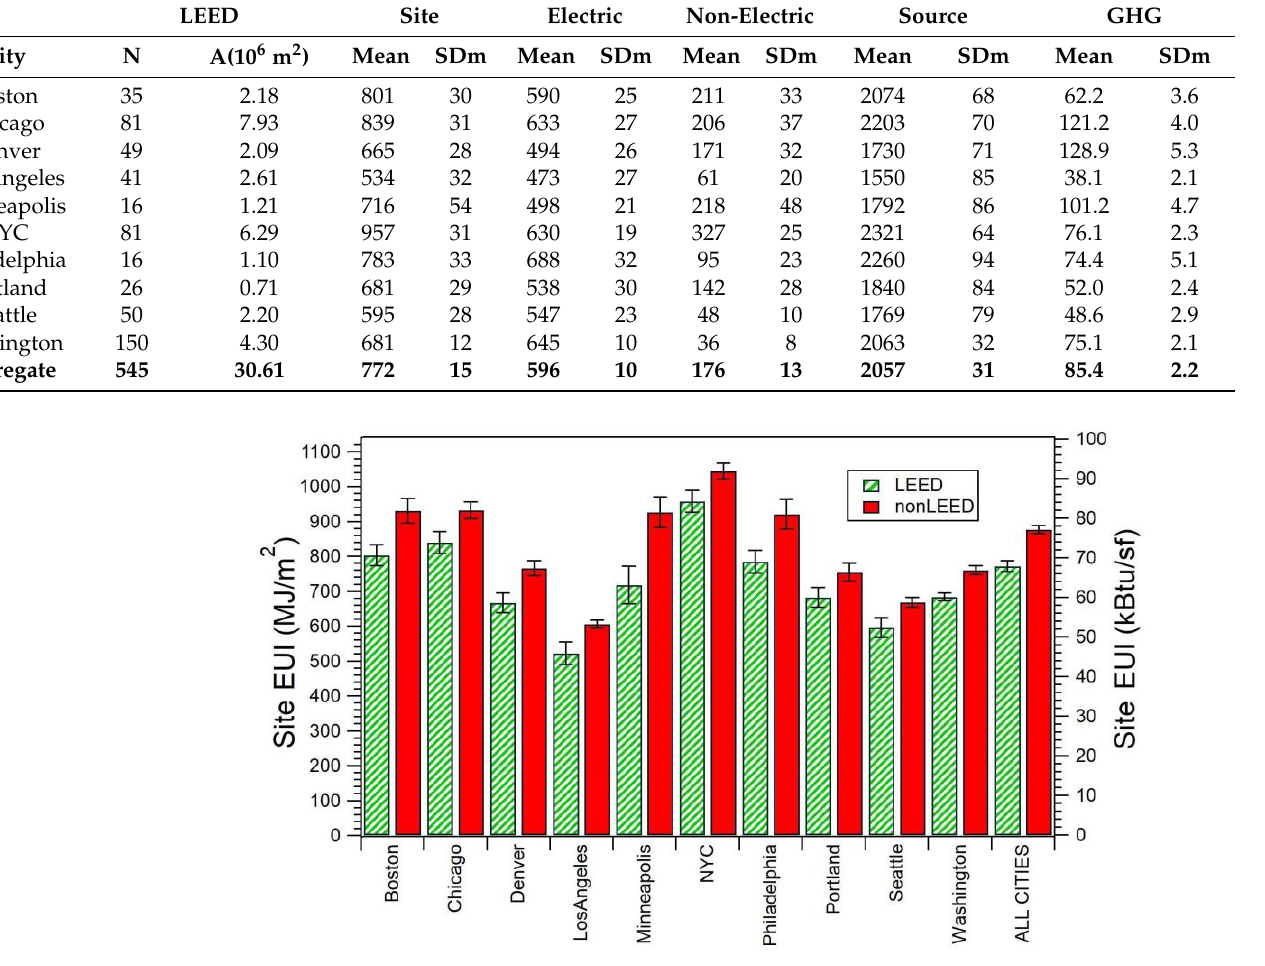
Figure 2. Area-weighted mean site EUI for LEED (Leadership in Energy and Environmental Design) offices in green and non-LEED offices in red, in ten cities and in aggregate (ALL CITIES). Error bars represent bootstrap standard deviations of weighted means.